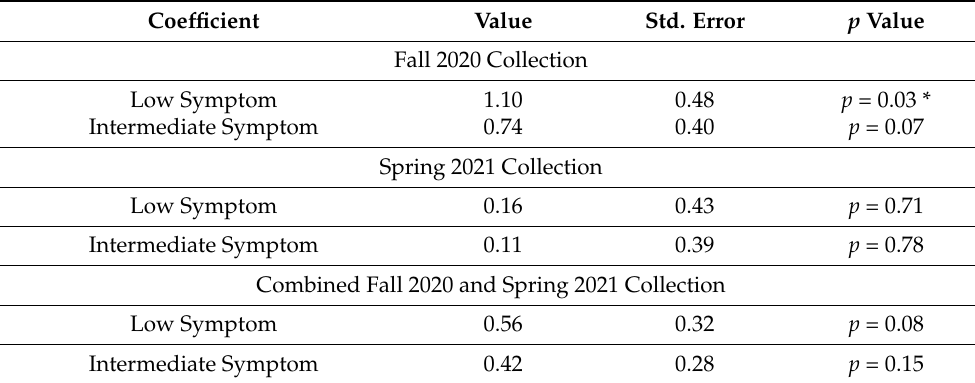
Table 3. GLS results (gls(log(Standardized Tip Abundance)~Condition)) of root tip abundance across trees of various BLD conditions for each collection and for combined collections data. Mean root tip abundances per gram of dried root mass varied significantly between trees of low- and high-symptom severity in the fall 2020 collection.